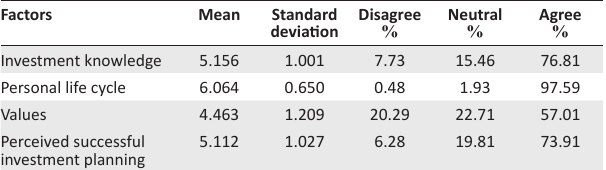
TABLE 4: Descriptive statistics